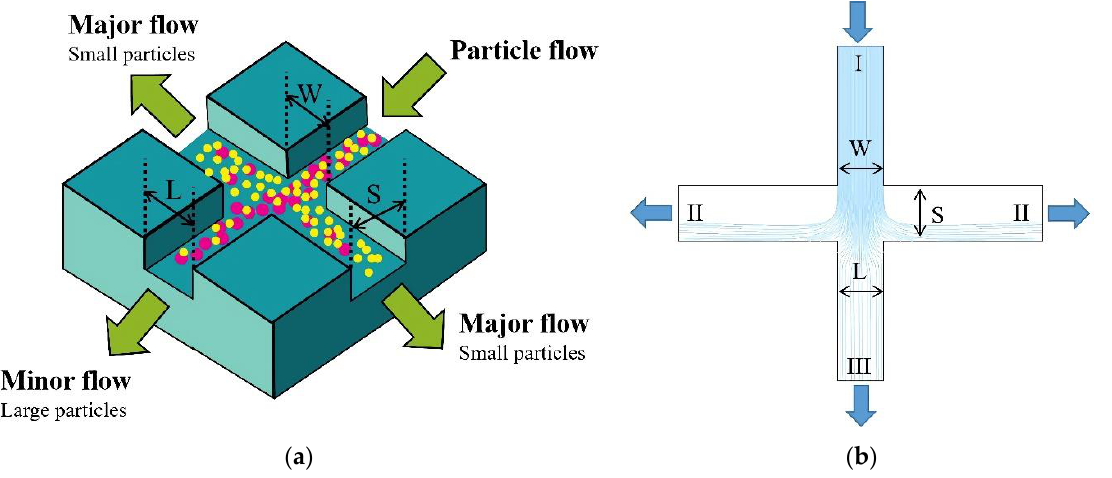
Figure 1. ( a ) 3D model of virtual impactor; ( b ) 2D model of virtual impactor. The yellow circles in Figure 1a are fine particles and the pink circles are coarse parti-